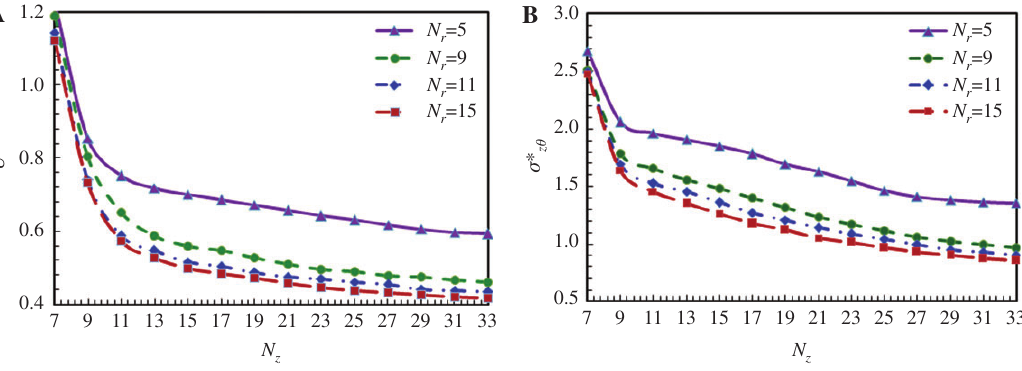
σ * at the inner surface of the FG hollow cylinder mid-length. zt